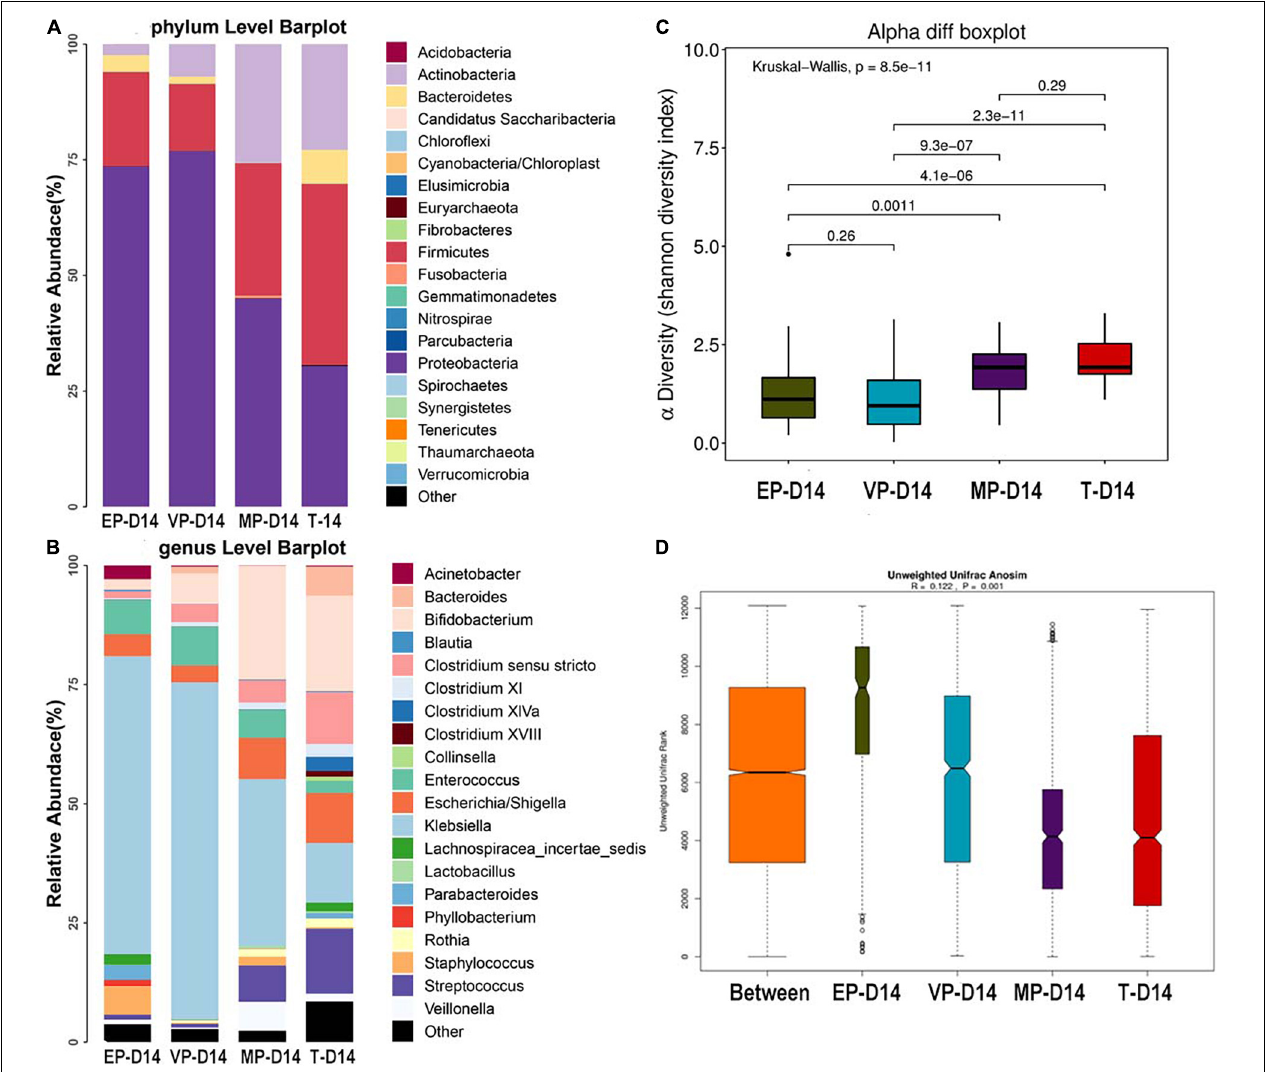
FIGURE 3 | The composition of gut microbiota from neonates with different gestational ages at 14 days after birth. EP, extremely preterm; VP, very preterm; MP, moderate to late preterm; T, full-term. (A) Comparison of abundance at phylum level. (B) Comparison of abundance at genus level. (C) Shannon diversity index of α diversity. (D) Anosim analysis of β